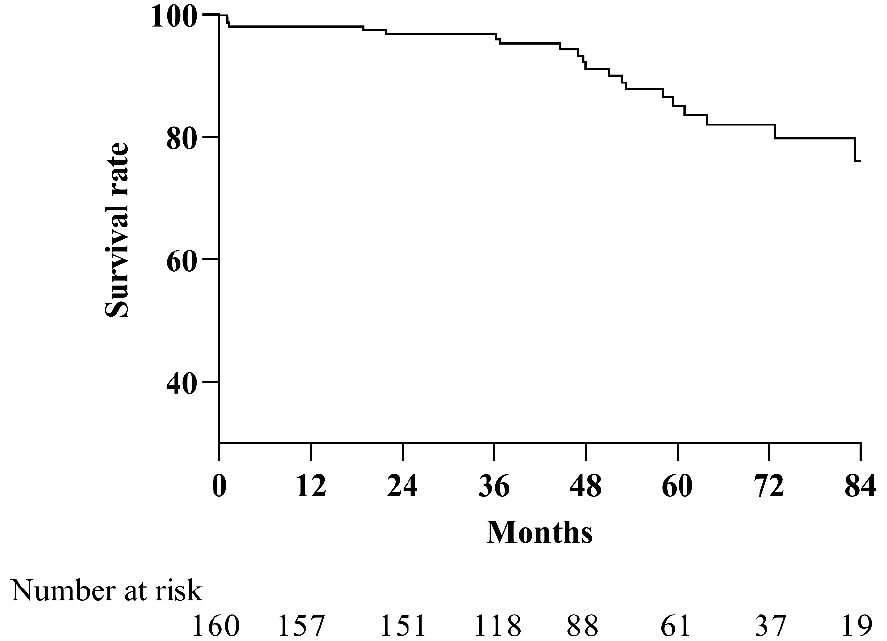
Figure 1. Kaplan–Meier survival for females with thromboembolic pulmonary hypertension. The estimated survival rates at 1, 3, 5, and 7 years for female patients were 98.1% (95% CI 96.0–100), 96.9% (95% CI 94.2–99.6), 85.1% (95% CI 78.1–92.2), and 76.2% (95% CI 65.2–87.2), respectively.